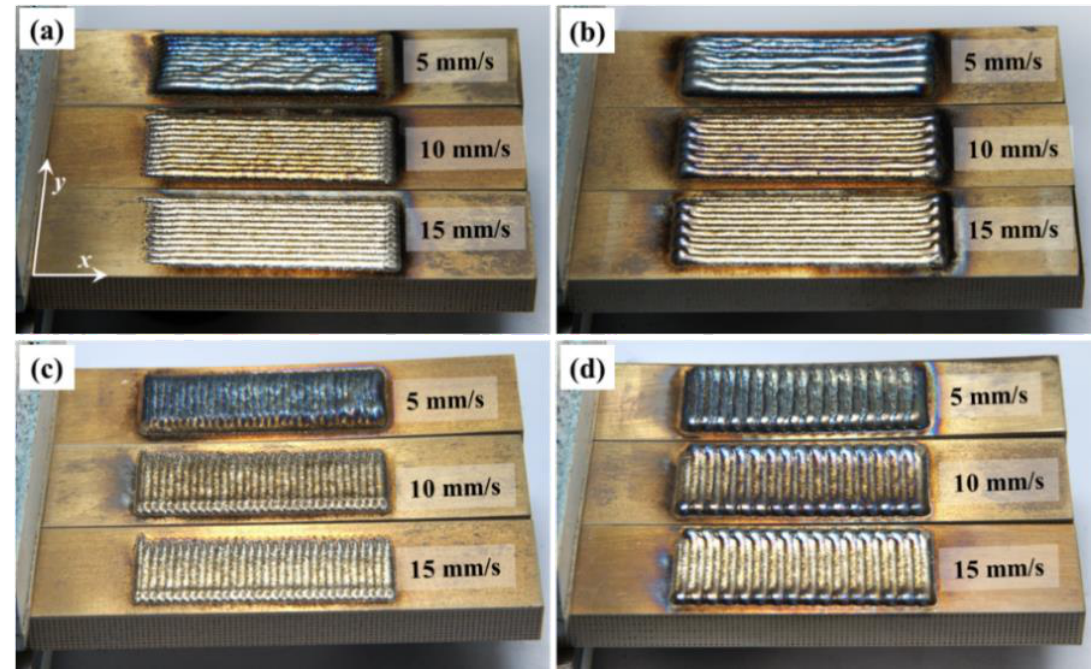
Figure 10. Cladding results under different scanning paths and scanning speeds. ( a ) Unidirectional scanning in x direction, ( b )serpentine scanning in x direction, ( c ) unidirectional scanning in y direction, ( d ) serpentine scanning in y